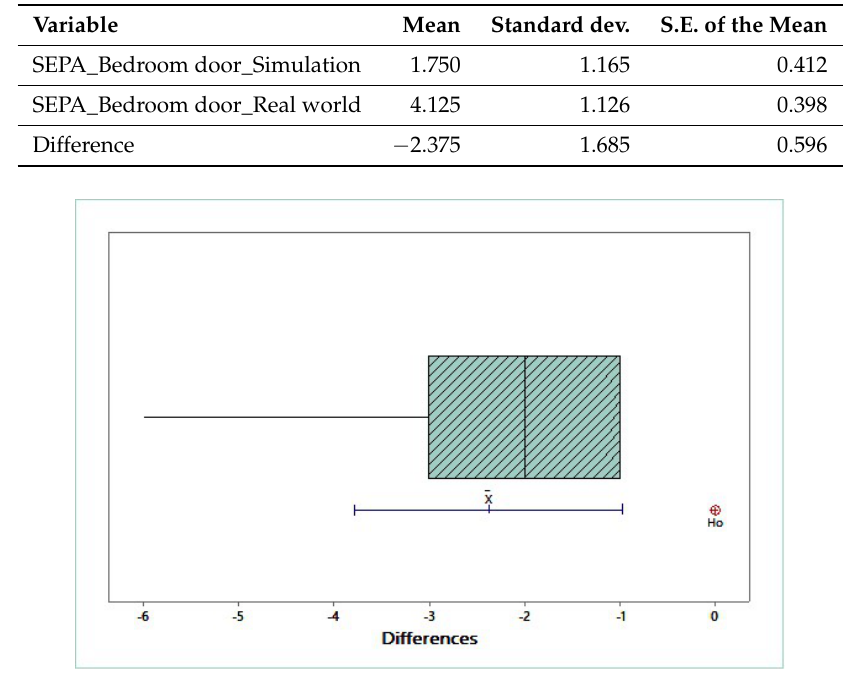
Figure 3. Contrast between real and simulated sensor events per activity (SEPA)—Bedroom door (Activities of Daily Living (ADL): Go to